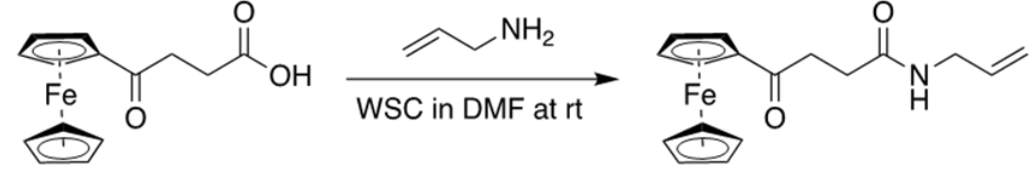
Figure 1. Preparation of the redox monomer allylaminocarboxy propionic-3-ferrocene (ACPF).